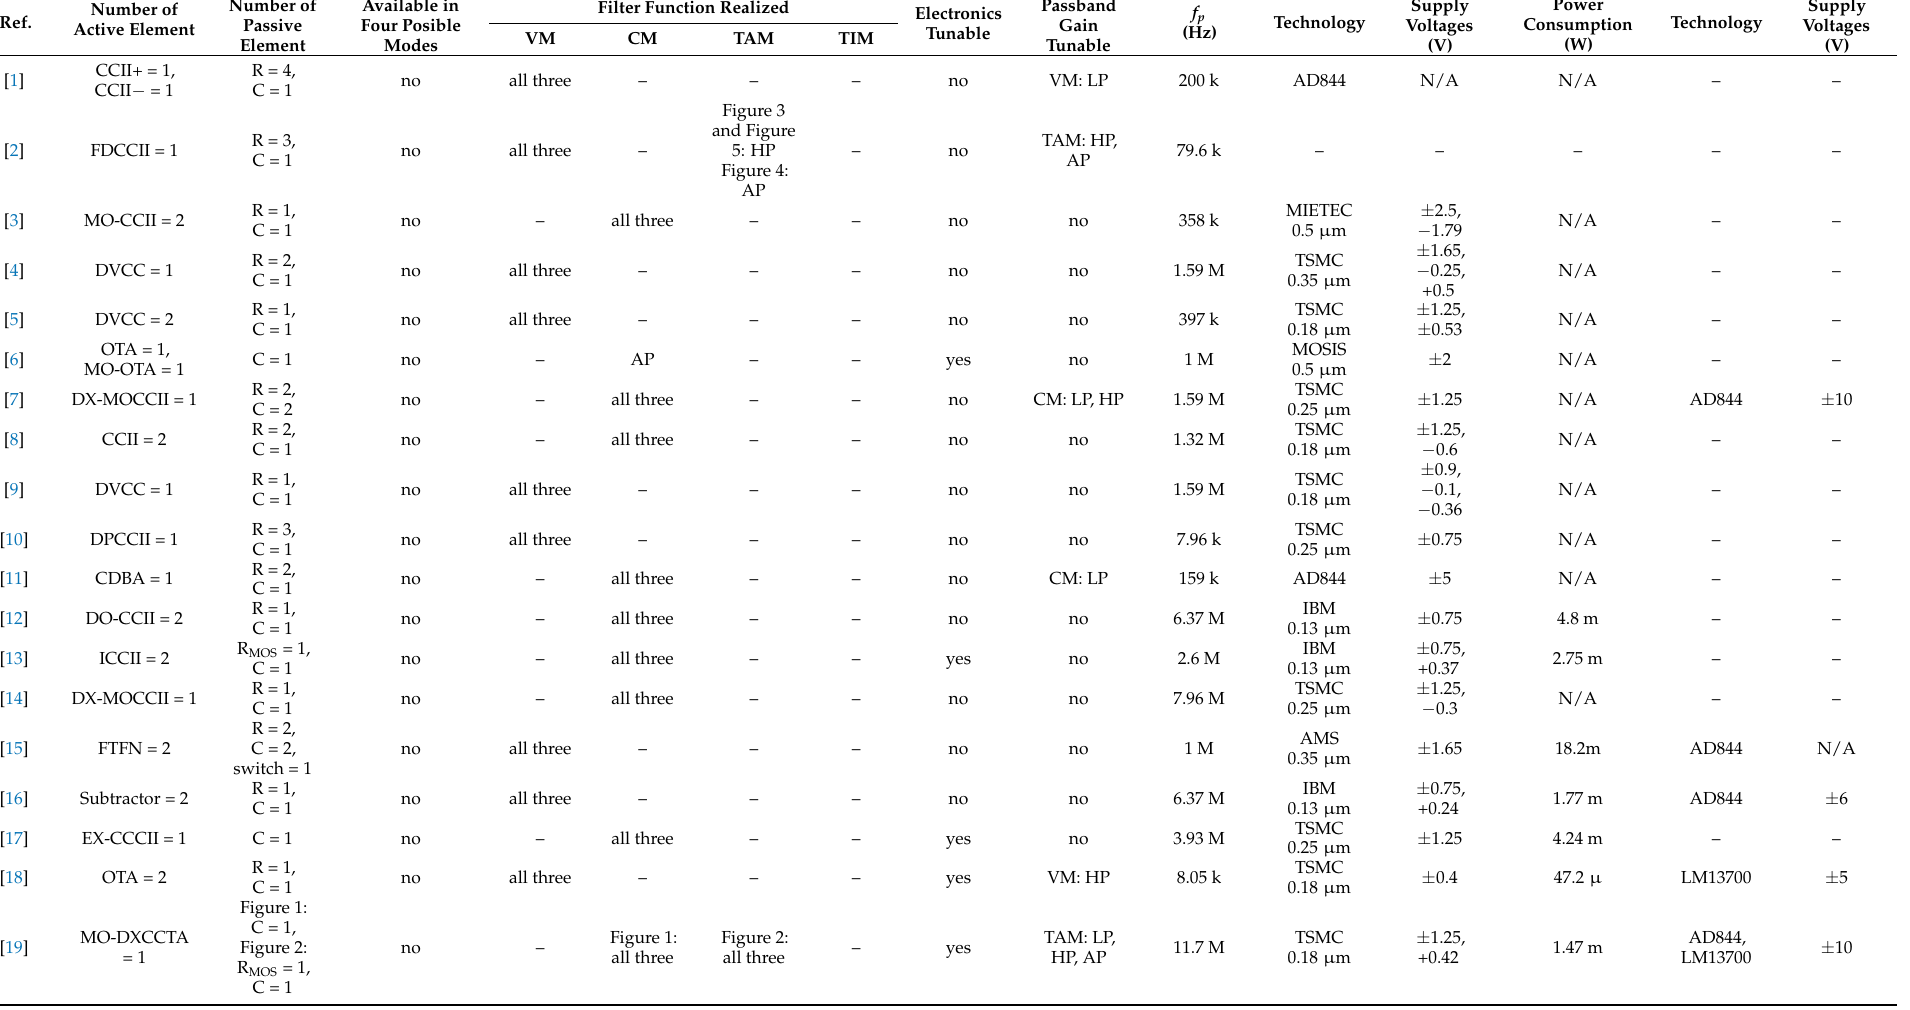
Table 1. Comparison among the earlier reported first-order universal filters [1–27] and the proposed circuit.